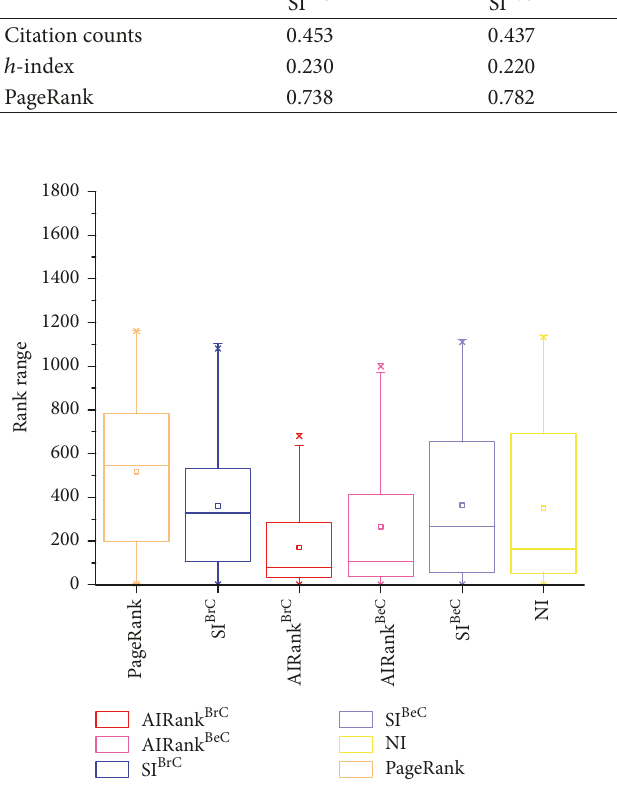
Figure 8: Boxplots of ranking positions for top scholars.